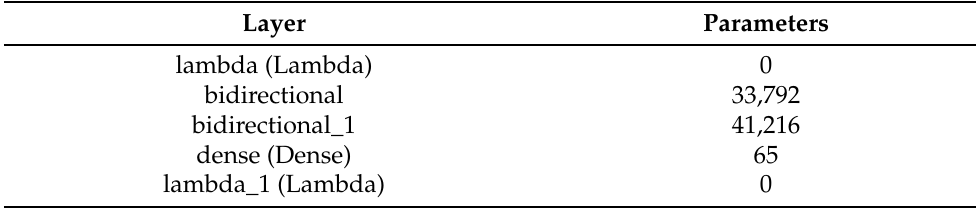
Table 4. Parameter breakdown per model—LSTM.